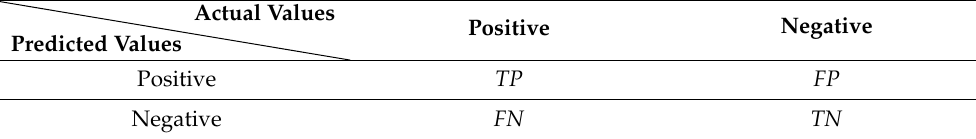
Table 2. Confusion matrix for